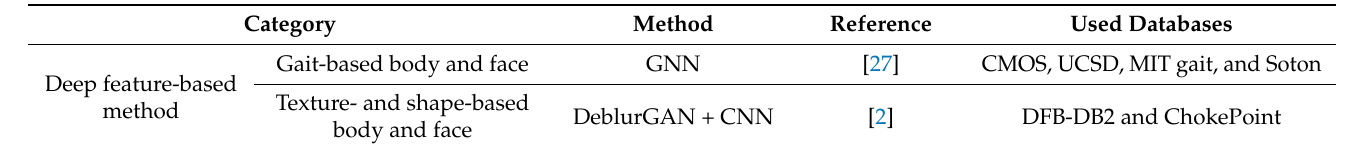
Table 2. Studies on face and body recognition robust to image blurring. All the methods used open